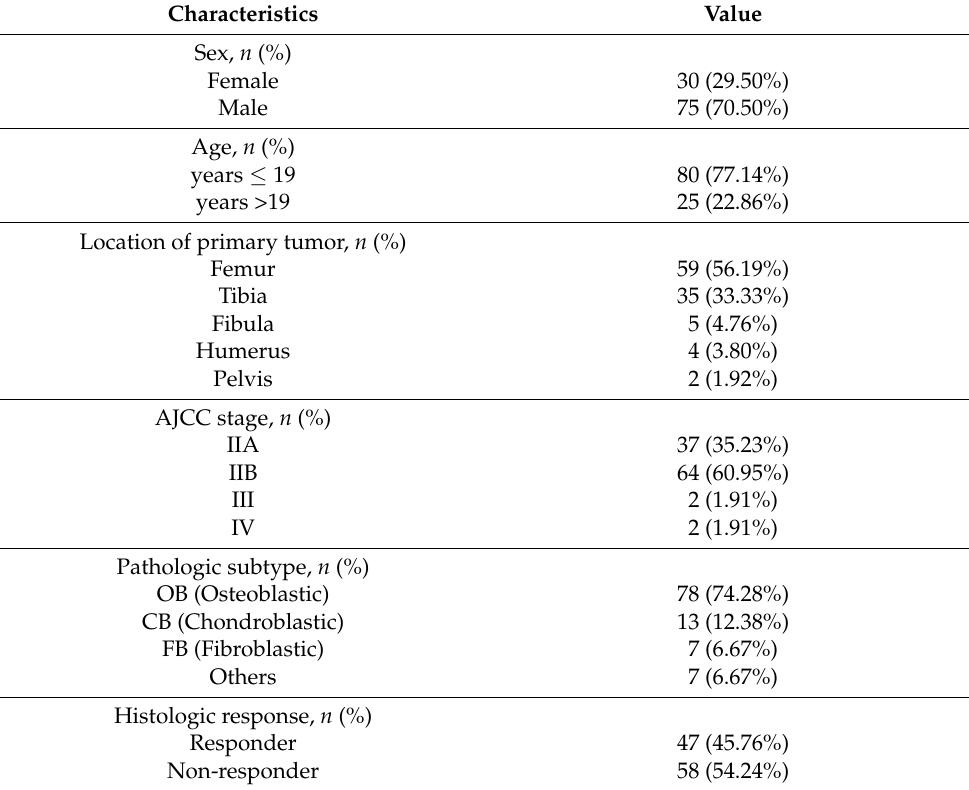
Table 1. Information on training and validation subjects with osteosarcoma who responded to neoadjuvant